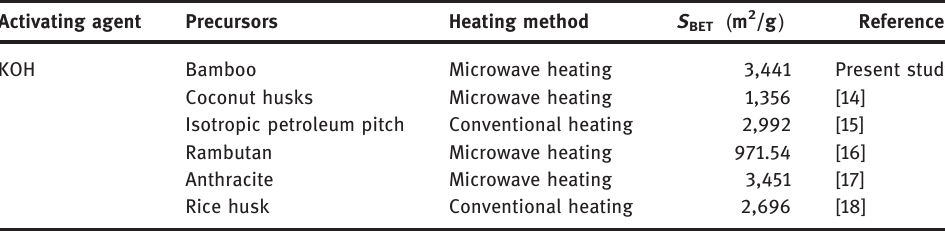
Table 3: Comparison surface area of activated carbon using KOH activating agent. Activating agent